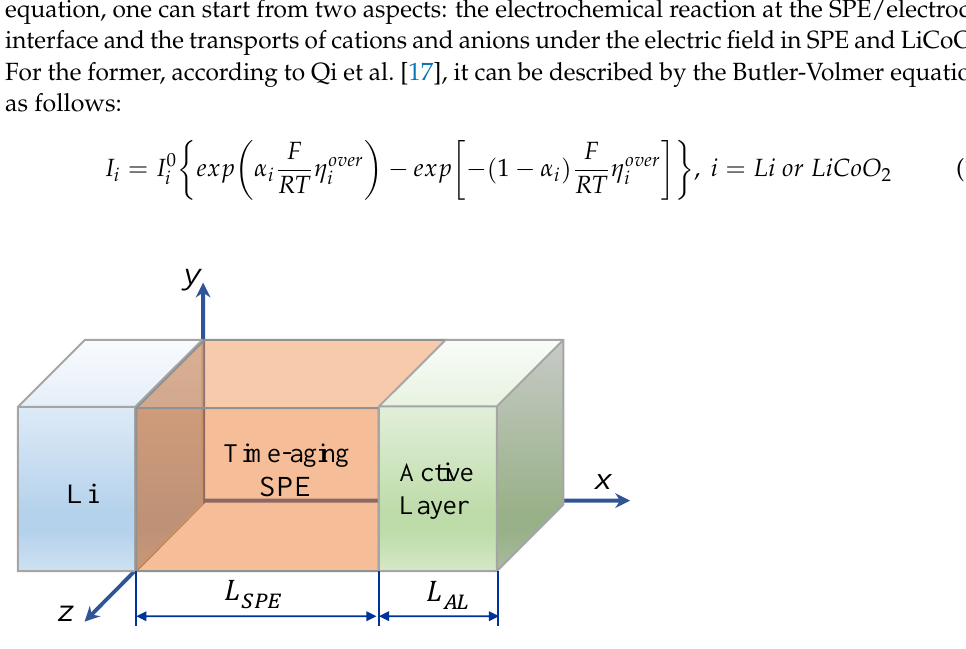
Figure 1. Schematic of an all-solid-state battery with time-aging solid polymer electrolytes (SPE). Here, I i and I 0 are the partial anodic/cathodic current at the electrode surface and i the related exchange current, respectively. To simplify the description, I 0 Appendix A. α i , F , and η over are the charge transfer coefficient, Faraday constant, and the i over potential, respectively. R is the molar gas constant, and T represents the